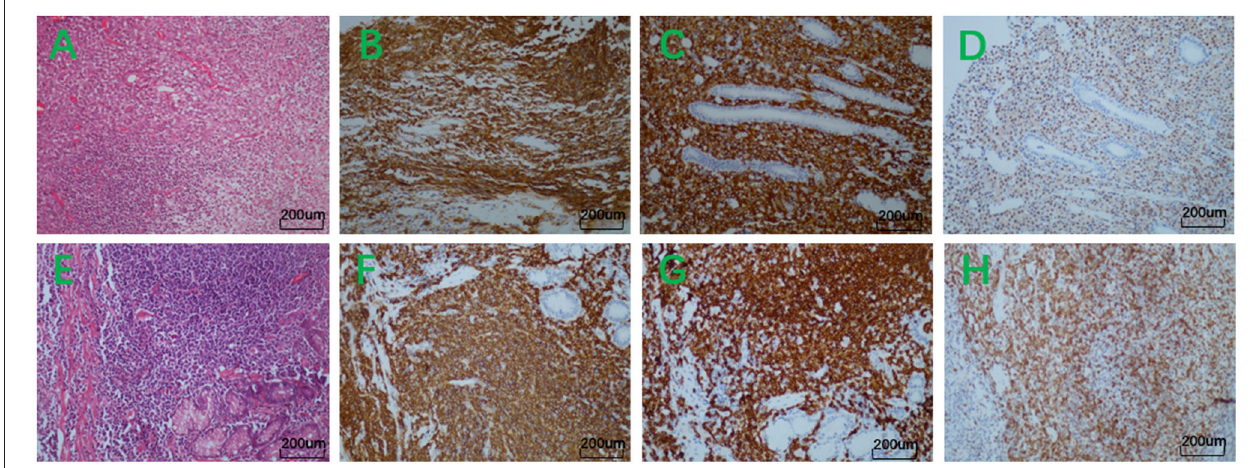
FIGURE 3 | (A) Hematoxylin-eosin staining × 200. (B) Immunohistochemistry showed positive reactivity for CD20. (C) Immunohistochemistry showed positive reactivity for CD79a. (D) Immunohistochemistry showed partially positive reactivity for Mum-1. (E) Hematoxylin-eosin staining × 200. (F) Immunohistochemistry